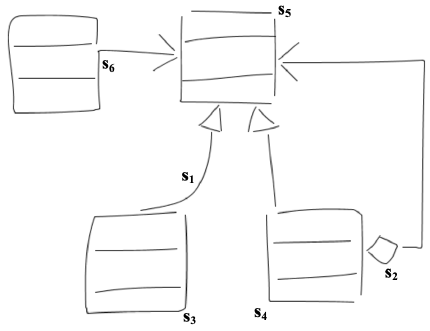
Figure 1. A sketched class